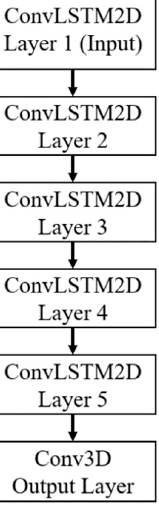
Figure 5. Final deep architecture.